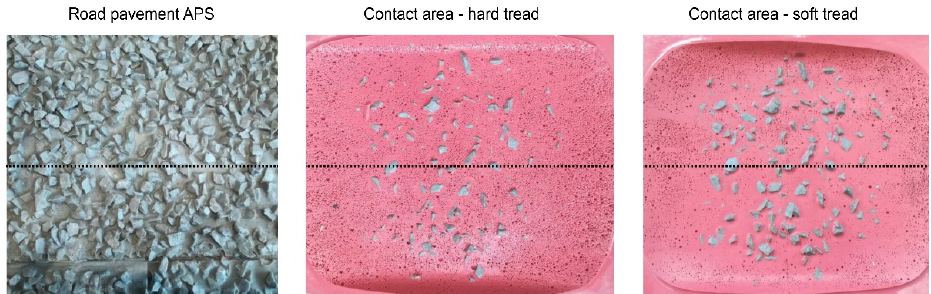
Figure 12. View of APS pavement and contact area of HARD and SOFT treads.